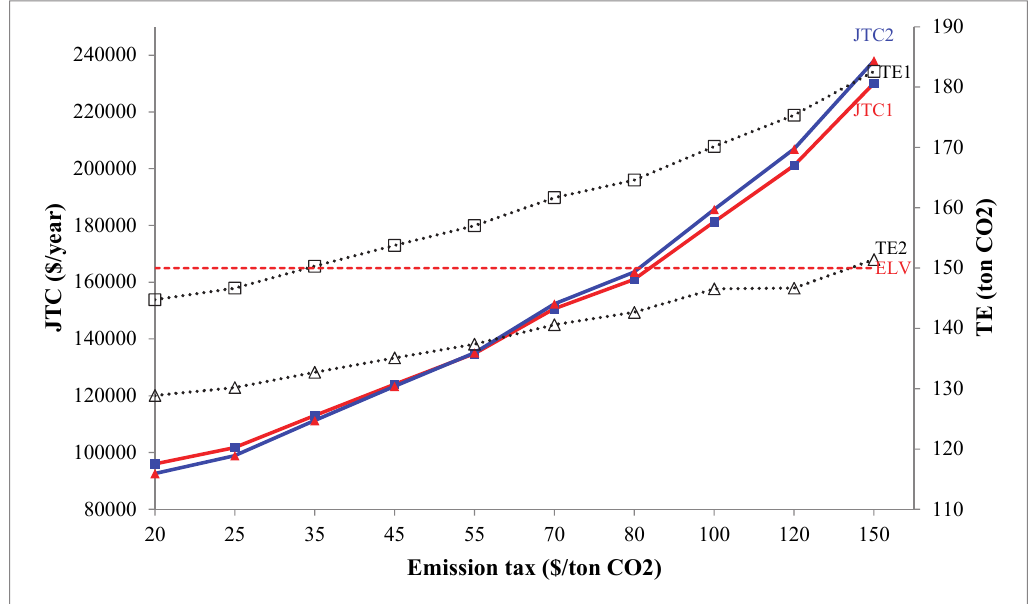
Fig. 6. The effect of changing in carbon emission tax on total cost and total GHG